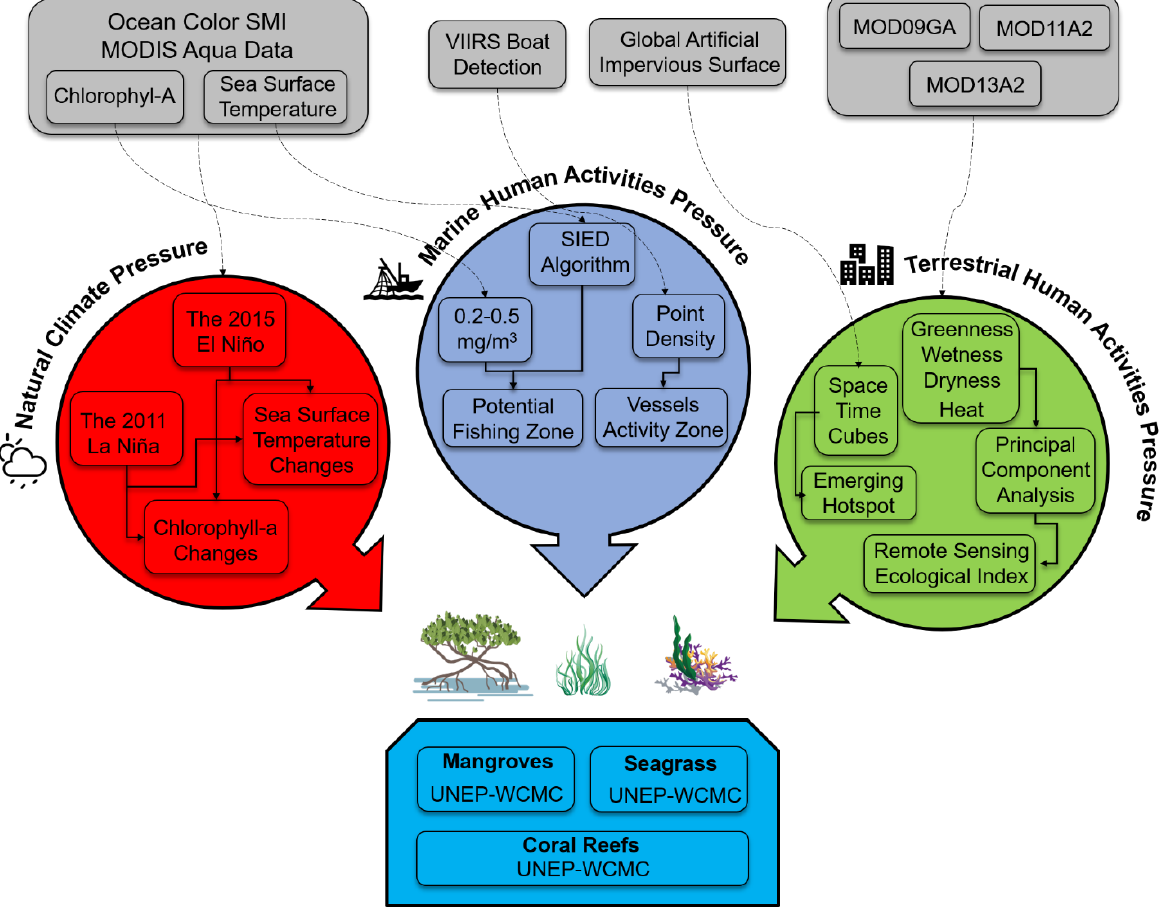
Figure 2. Research framework of this study. SIED: single image edge detection and UNEP-WCMC: the United Nations environment program world conservation monitoring center.